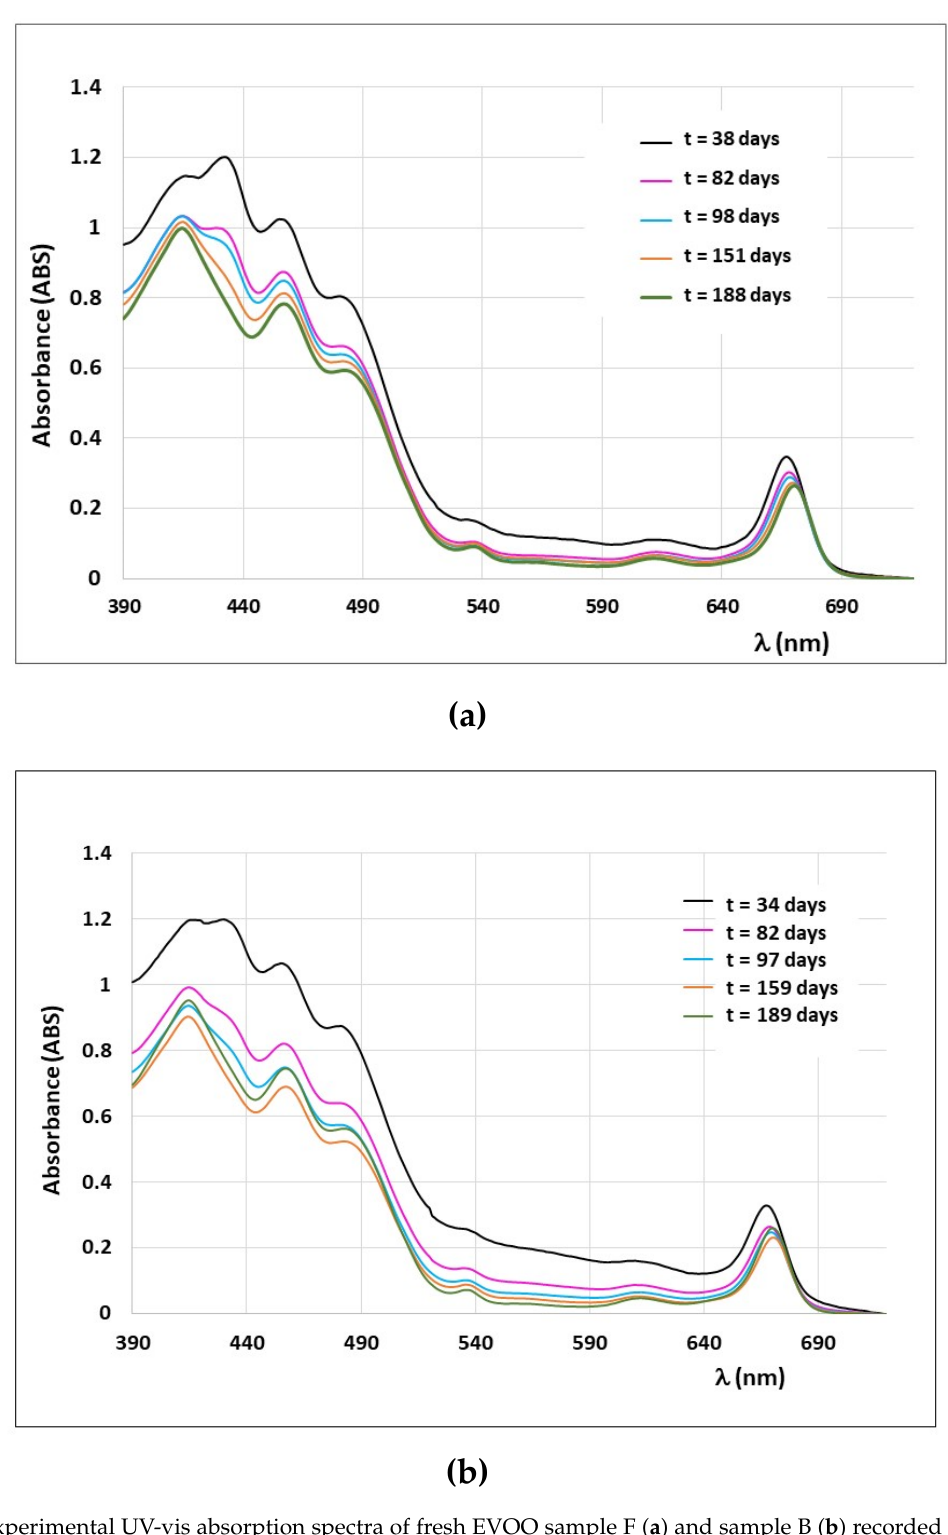
Figure 9. Experimental UV-vis absorption spectra of fresh EVOO sample F ( a ) and sample B ( b ) recorded with a quartz cuvette (optical path of 0.5 cm) at different times. Spectra of different color were recorded at different times, as indicated in the legend: ‘t’ stays for the number of days after the olive oil production.